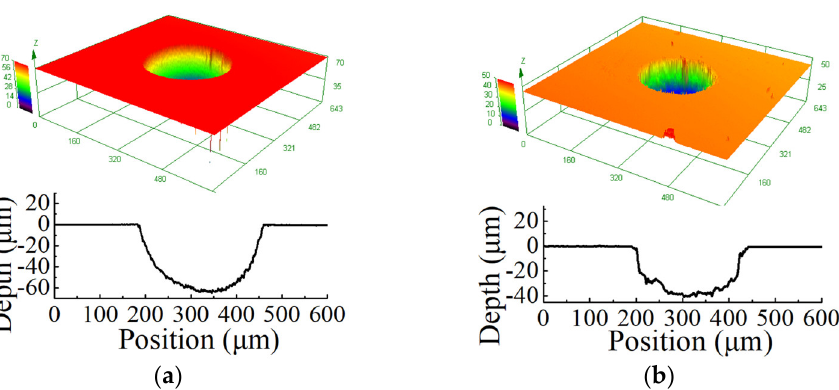
Figure 9. Micro dimple generated with different modes. ( a ) unidirectional pulse; ( b ) bidirectional pulse.